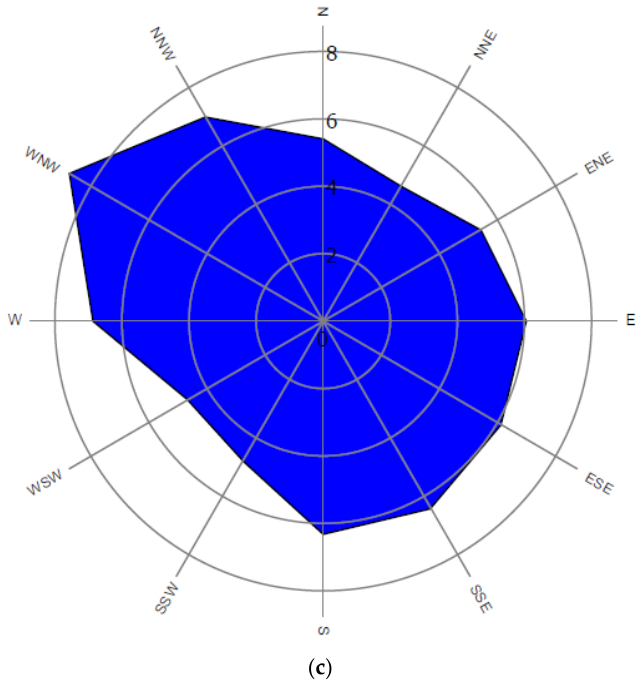
Figure 13. Wind data for annual energy production (AEP) calculation at Jeju Island, South Korea. ( a ) Site map; Jeju Island, South Korea, Scale 1:75,000. ( b ) Weibull distribution with respect to wind speed. ( c ) Mean wind speed (m/s) with respect to wind direction.